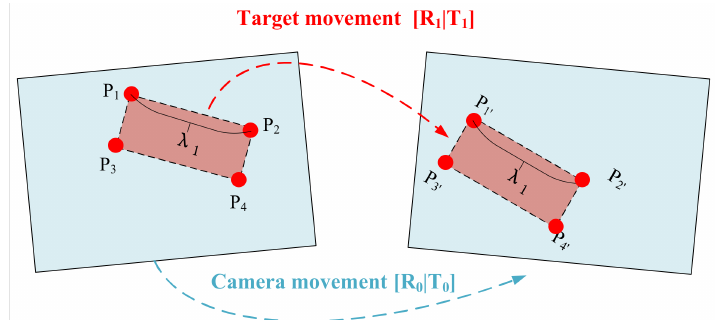
Figure 10. The dynamic target in the continuous frame of the mobile